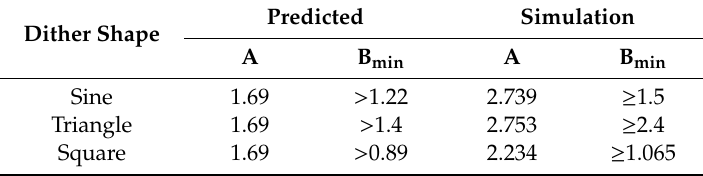
Table 3. The results of analytical and the simulation studies for the relay feedback system. Predicted Simulation Dither Shape B min A B min A Sine 1.69 > 1.22 2.739 ≥ 1.5 Triangle 1.69 > 1.4 2.753 ≥ 2.4 Square 1.69 > 0.89 2.234 ≥ 1.065